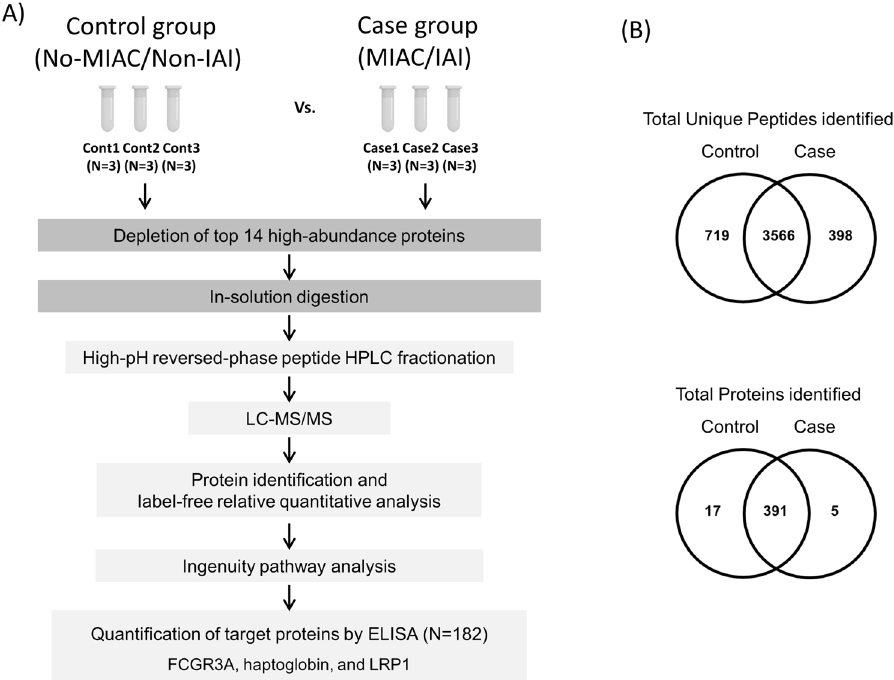
Figure 1. ( A ) Schematic workflow for the discovery (label-free LC–MS/MS) and verification (immunoassay) experiments. Three sets of pooled plasma samples from control (non-MIAC/IAI) and case (MIAC/IAI) groups were subjected to immunoaffinity depletion to remove the 14 most abundant proteins followed by tryptic digestion. Peptides were fractionated with high-pH reversed phase chromatography, after which were subjected to LC–MS/MS followed by label-free quantitative analysis based on peak intensities. Differentially expressed proteins were further investigated by IPA and the DEPs of interest were validated by ELISA. ( B ) Venn diagrams showing the distribution of common and uniquely peptides (above) and proteins (below) identified in the LC–MS/MS analyses. MIAC microbial invasion of the amniotic cavity, IAI intra-amniotic inflammation,